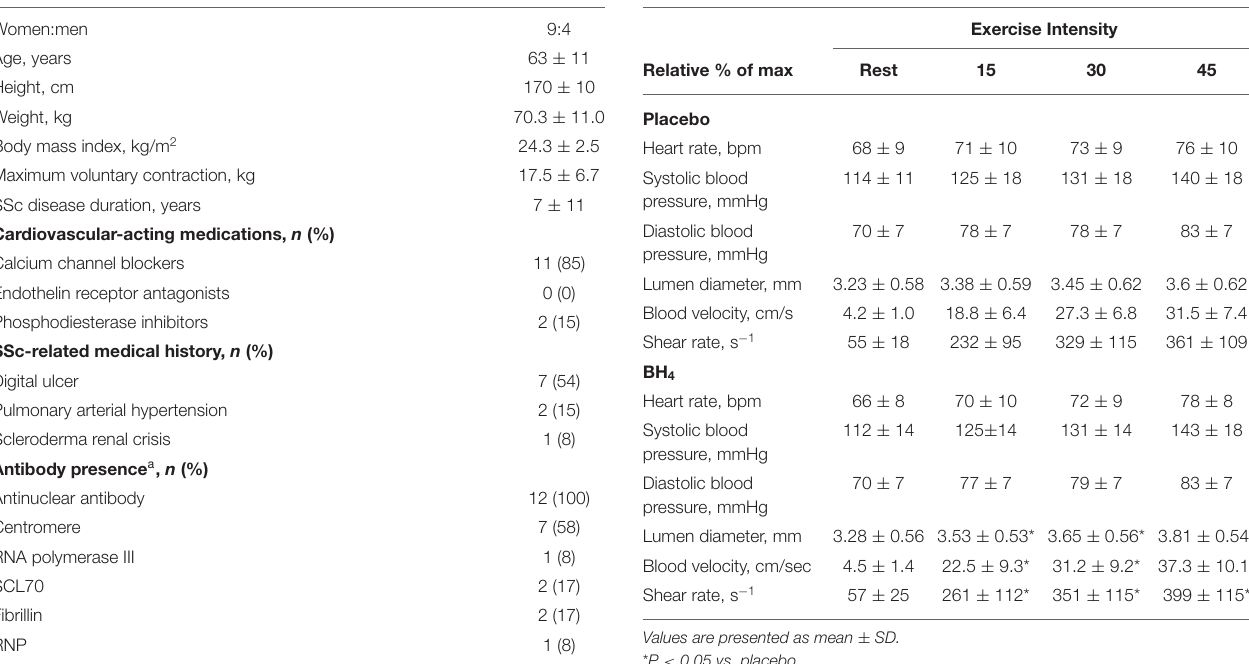
TABLE 1 | Participant characteristics. TABLE 2 | Cardiovascular variables at rest and during